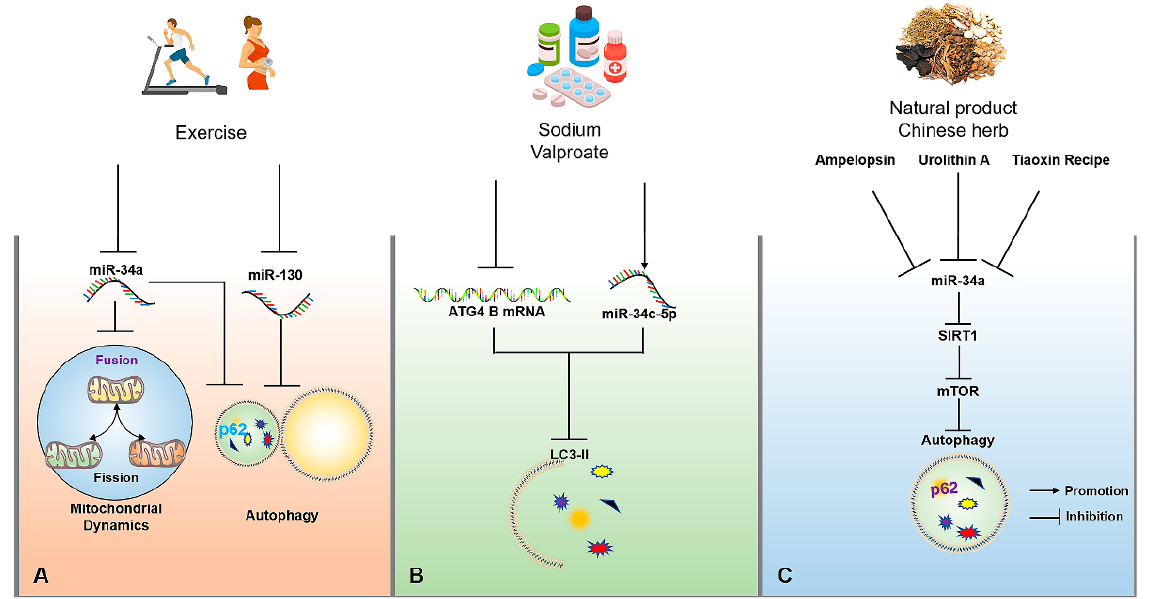
Figure 1. The molecular mechanisms of macroautophagy, chaperone ‐ mediated autophagy, mi ‐ croautophagy, and autophagy ‐ lysosome ‐ associated transcription factors. ( A ) The increased AMP/ATP ratio activates AMPK to inhibit mTOR; and activates the ULK1 complex (ULK1 ‐ ATG13 ‐ ATG101 ‐ FIP200) to further induce the completion of autophagy process through a series of autophagy ‐ related proteins, including PI3K ‐ ATG2 ‐ ATG18 complex, and ATG5 ‐ ATG12 ‐ ATG16L1 complex. ( B ) HSC70 realizes the degradation by recognizing the KFERQ motif and transporting the substrate protein into lysosomes through LAMP2A. ( C ) HSC70 binds to KFERQ ‐ carrying proteins and degrades the substrates through ESCRT complexes for accomplish ‐ ing substrate transport and lysosome phagocytosis. ( D ) The increased AMP/ATP ratio activates AMPK for inhibiting mTOR and regulating the lysosomal Ca 2+ microenvironment to promote the nucleus translocation of TFEB after dephosphorylation, thereby binding autophagy ‐ and lyso ‐ some ‐ related genes, and enhancing autophagic flux. The ↑ in red color represents the increased AMP/ATP ratio; the → and ┤ in black color represent the promotion and inhibition, respectively;